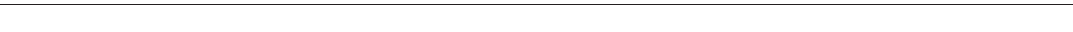
Fig. 3 PIXR facilitates Borrelia colonization and larval molting. a Nymphal engorgement weights in pixr -silenced and mock-injected nymphs. Each data point represents one tick: b qRT-PCR assessment of pixr transcript levels; c Western blot assessment of PIXR and Salp25D expression using a pool of two guts per lane. Lanes 1 – 4, ds gfp RNA-injected ticks and lanes 5 – 8, ds pixr RNA-injected ticks; protein markers (Precision Plus Biorad protein markers) are shown in lane M and their cognate molecular weights denoted to the left. d Quanti fi cation of PIXR expression normalized to that of Salp25D; e qRT-PCR assessment of Borrelia fl aB levels in midguts; f visualization of B . burgdorferi burden by immuno fl uorescence microscopy using anti- B . burgdorferi antibody in the guts of ds gfp or ds pixr RNA microinjected pathogen-free nymphs after repletion on B . burgdorferi -infected mice; g Borrelia fl aB levels in guts; and h Visualization of B . burgdorferi burden by immuno fl uorescence using anti- B . burgdorferi antibody in guts of nymphs repleted on ovalbumin-(anti-Ova) or rPIXR-immunized mice (anti-PIXR). Each data point in b , e and g represents a pool of two to three guts. i Borrelia fl aB levels in larvae repleted on ovalbumin (anti-Ova) or rPIXR-immunized mice (anti-PIXR). Each data point represents a pool of fi ve larvae. j Repleted larvae were allowed to molt to the nymphal stage and molting ef fi ciency determined. Each data point represents the percentage of larvae that molted to nymphs. Horizontal bars represent the median. Mean values signi fi cantly different in a non-parametric Mann – Whitney test ( P < 0.05) indicated. Scale bars, 10 μ m ( f , h